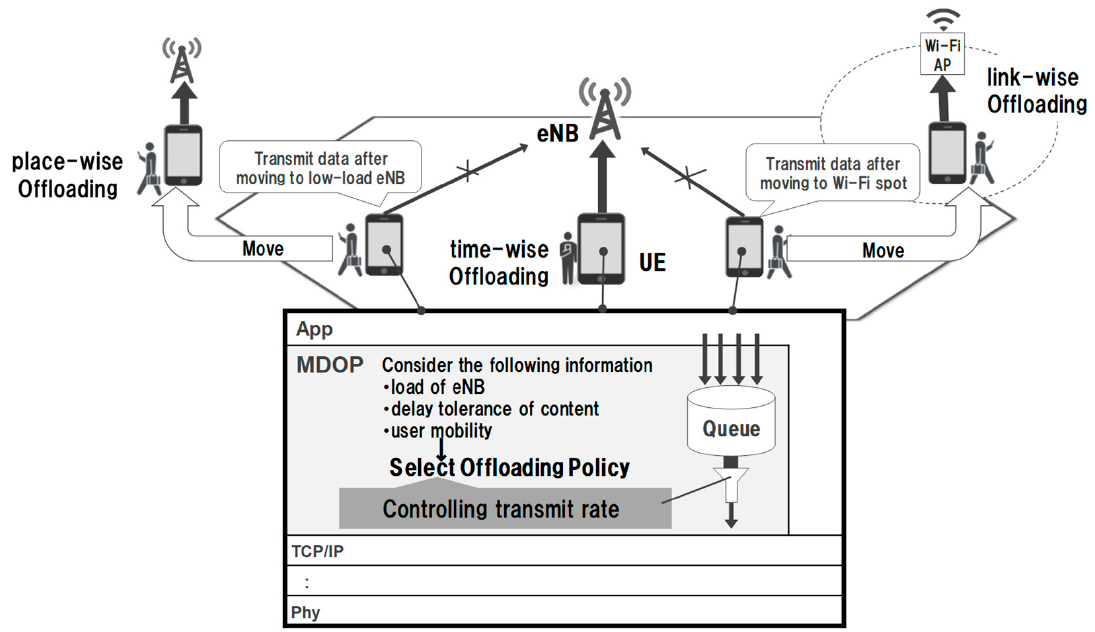
Figure 2. Overview of the mobile data offloading protocol (MDOP).